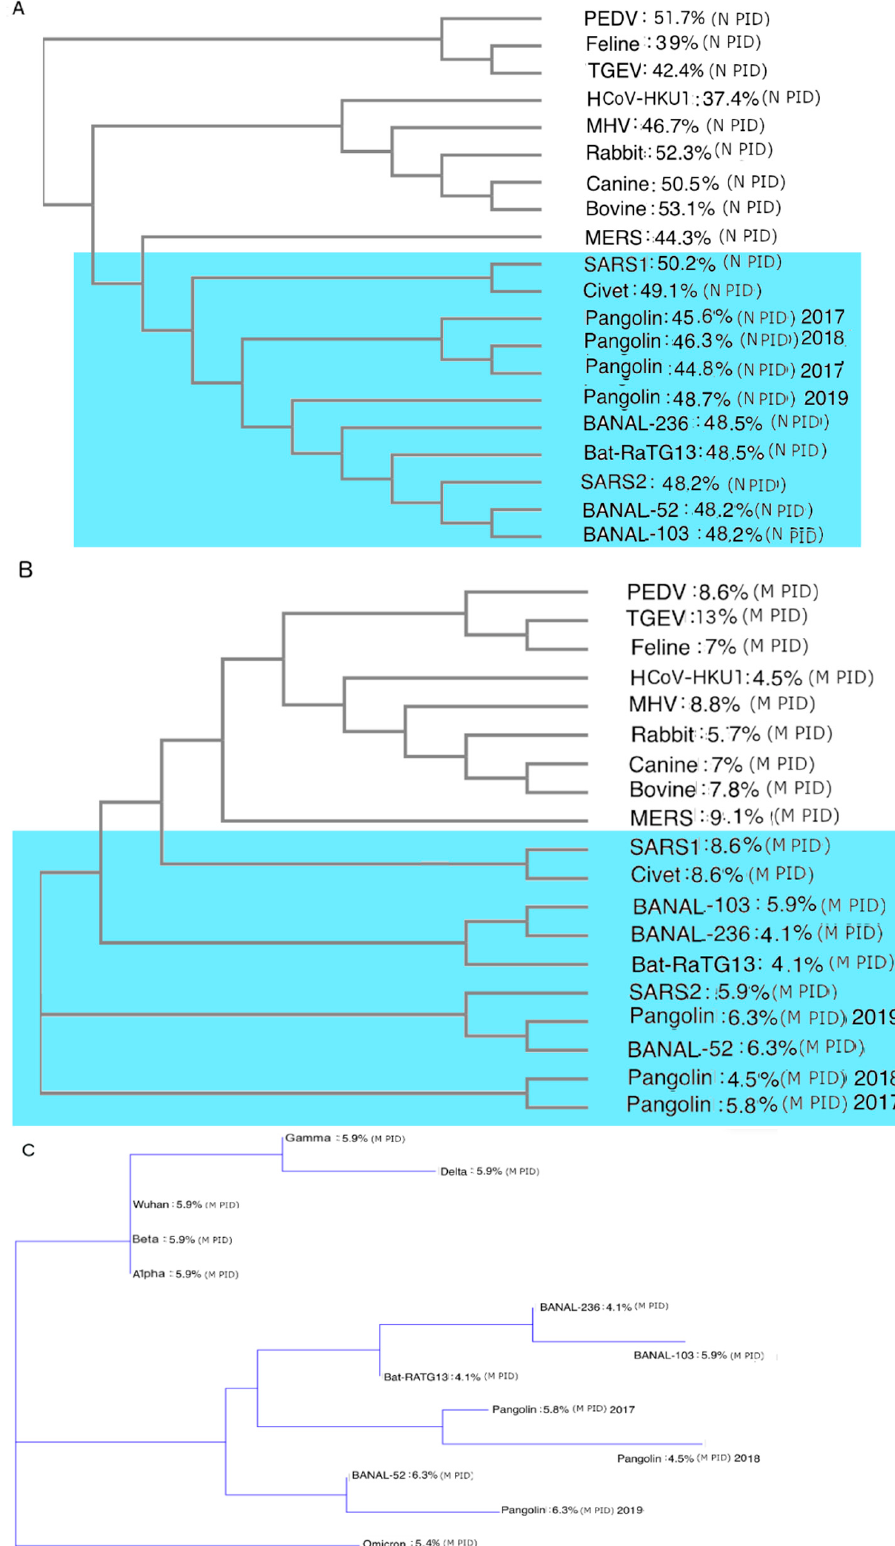
Figure 3. CoV Phylogenetic Trees with PID N and PID M Values. ( A ) Phylogenetic trees of CoVs using N proteins. Analysis was performed using CLUSTAL OMEGA [78]. ( B ) Phylogenetic trees of CoVs using M. Analysis was performed using CLUSTAL OMEGA [78]. ( C ) Phylogenetic trees of COVs related to SARS ‐ CoV ‐ 2 using M protein. Analysis was performed using CLUSTALW [79]. Blue region denotes viruses related to SARS ‐ CoV ‐ 2.